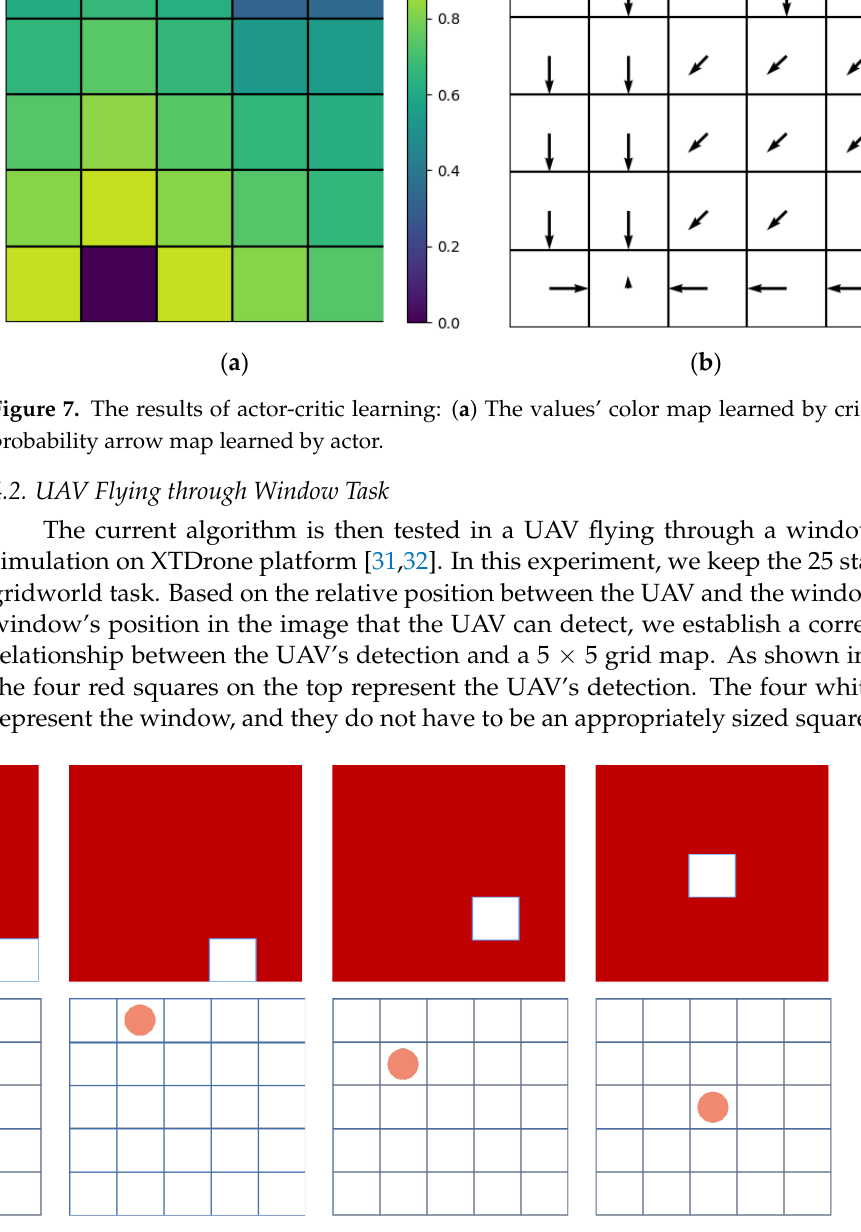
Figure 8. The corresponding relationship between UAV’s detection and 5 × 5 grid map. The four red squares on the top represent the wall, on which the white squares represent the window. The four white squares could be larger or smaller. The four 5 × 5 grid maps on the bottom represent the states.